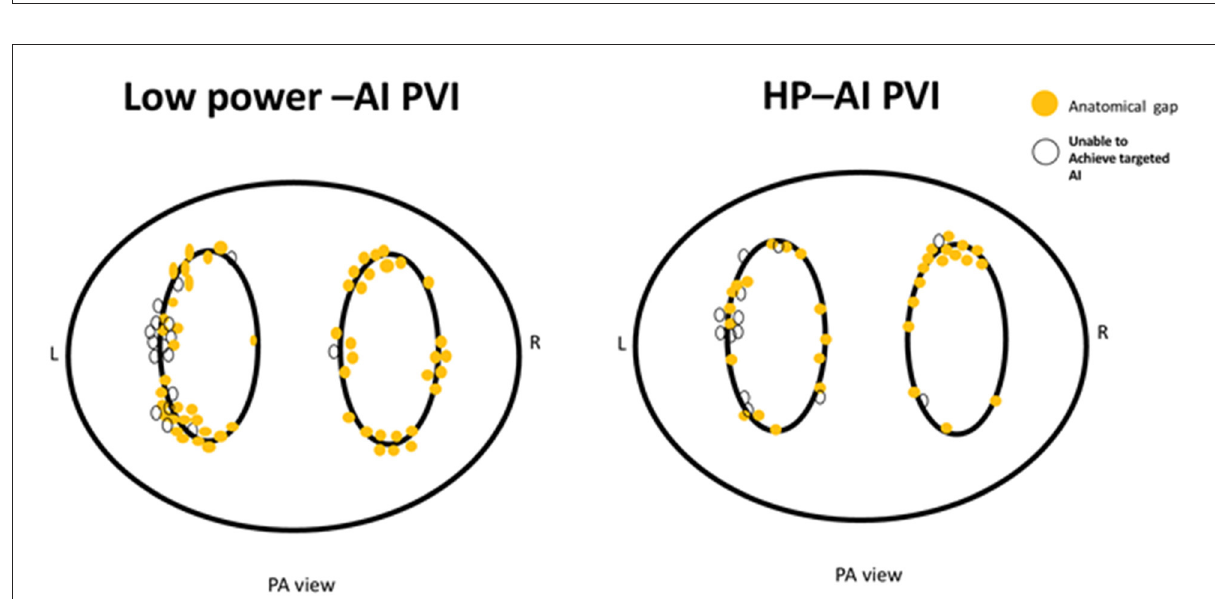
FIGURE3 The distribution of anatomical leakages after PVI (yellow dots) and sites of below-target AI (white